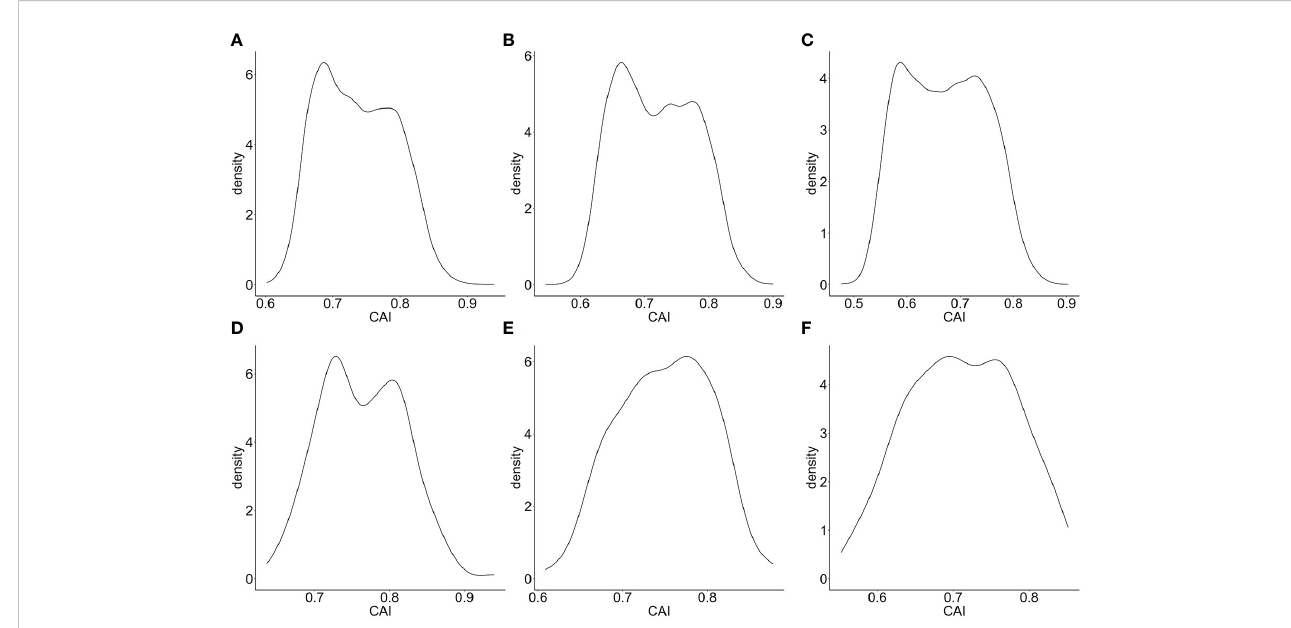
FIGURE 2 Density plot for the distribution of CAIs in the top 5000 (A – C) /200 (D – F) highly expressed genes of bulk RNA-seq datasets corresponding to CD4+ Tfh (A, D) , Kupffer cells (B, E) and Langerhans cells (C, F)